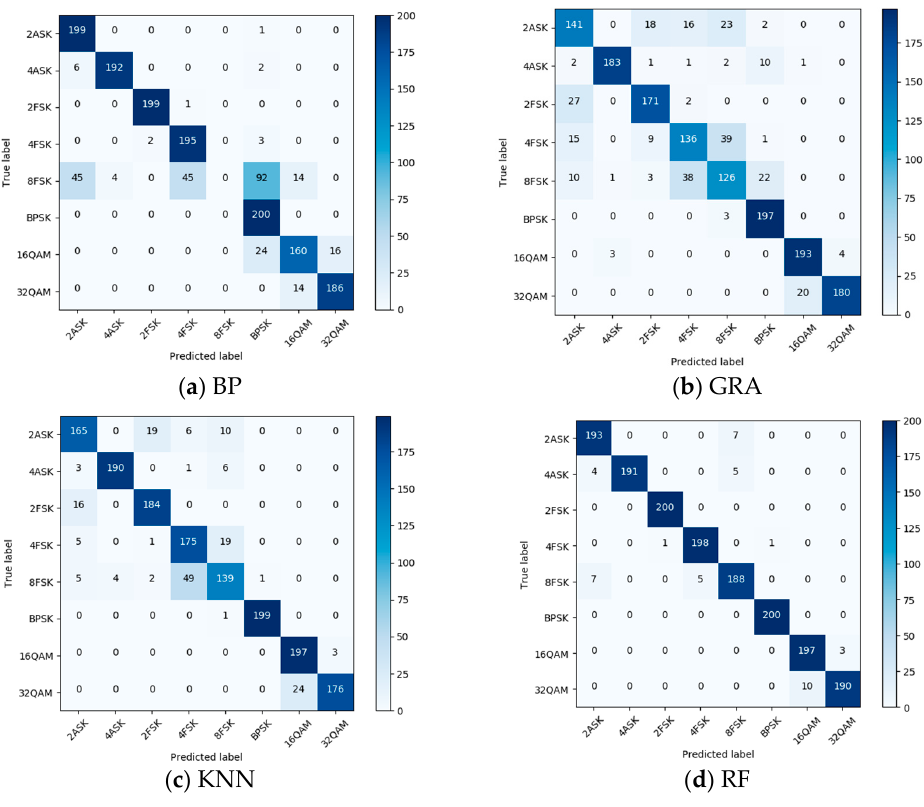
Figure 6. Confusion matrices at 10 dB SNR.